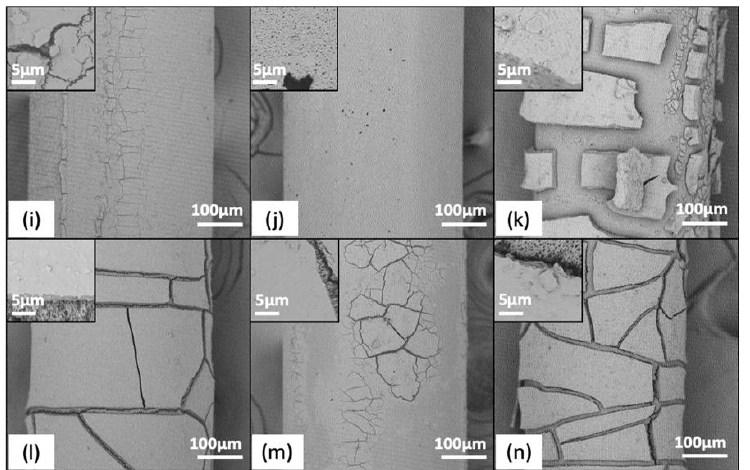
Figure 4. SEM images of fouling control on F2 for modules filtered with BacChem influent by backwashing solutions. Outer membrane surface at 500× and 15,000× (insets), showing fouling layer after BacChem filtration with final backwash using ( i ) DI water, ( j ) bleach, and ( k ) vinegar and without final backwash ( l ) DI water, ( m ) bleach, and ( n ) vinegar.